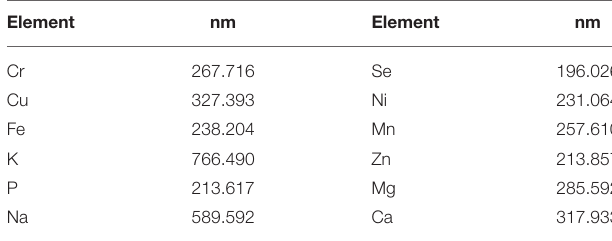
TABLE 2 | Analytical line length (nm) utilized for